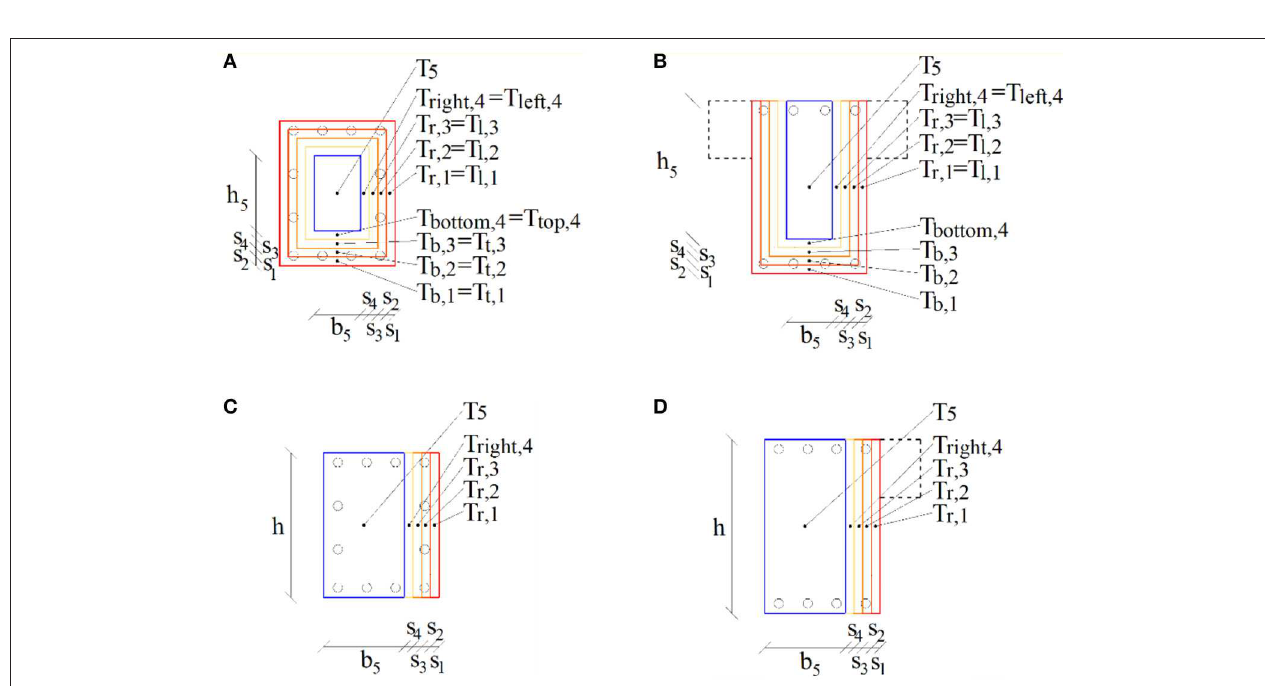
FIGURE 4 | Thermal mappings of interior r.c. frame members for the F0 fire scenario. (A) R45: columns. (B) R FC : columns. (C) R MC : columns. (D) R SC : columns. (E) R45: beams. (F) R FC : beams. (G) R MC : beams. (H) R SC : beams.